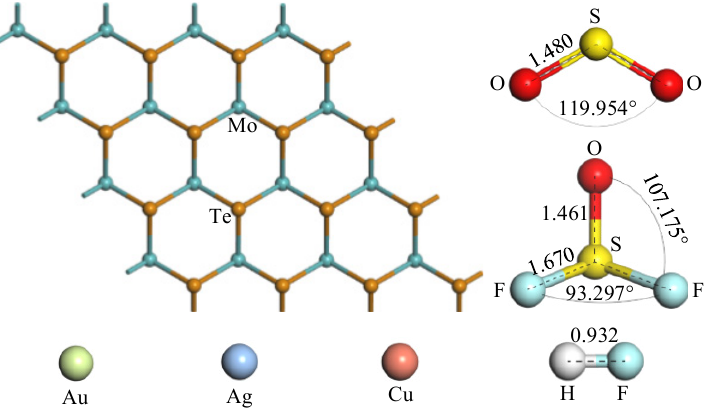
Figure 1. The optimized structures of the pristine MoTe 2 , TM atoms, SO 2 , SOF 2 , and HF gases. The unit is Å.